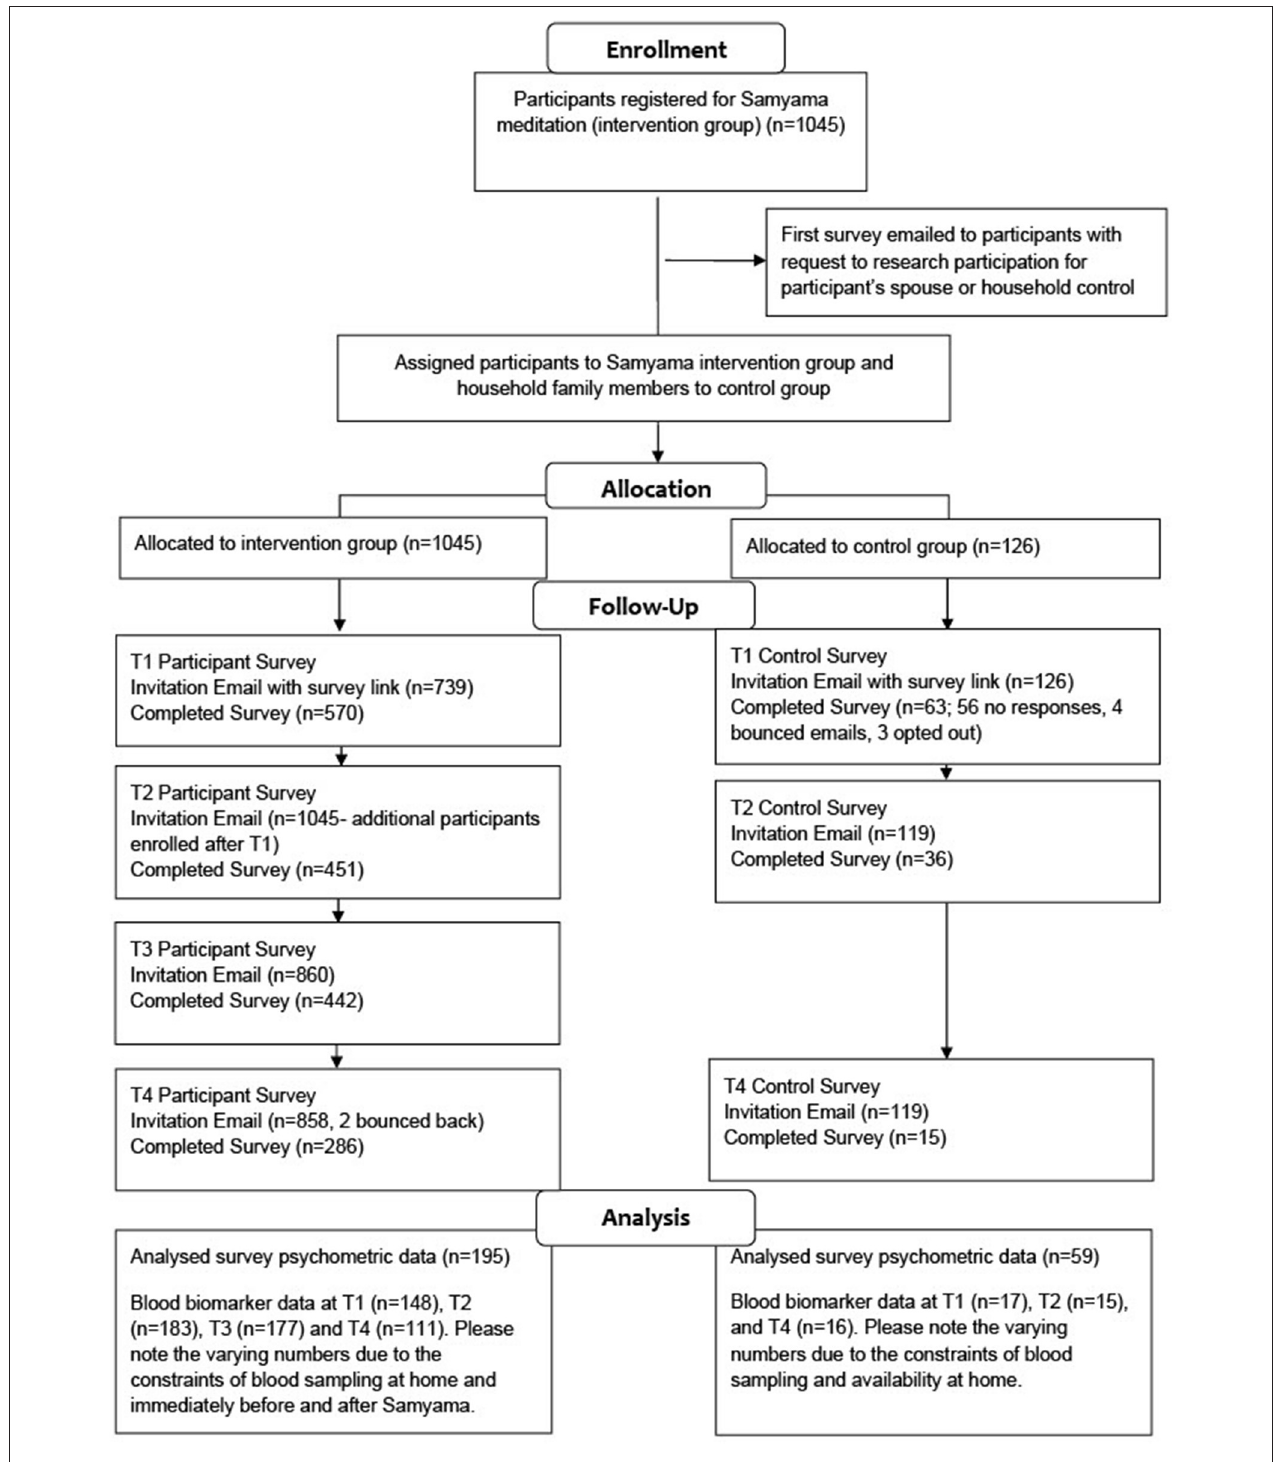
FIGURE 2 | CONSORT diagram. They were asked to complete all surveys and were given the option of blood sampling at time-points 1, 2, and